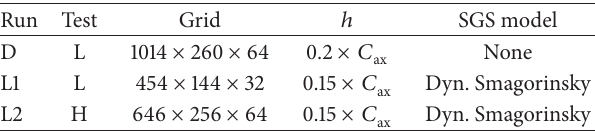
Table 2: Summary of the test